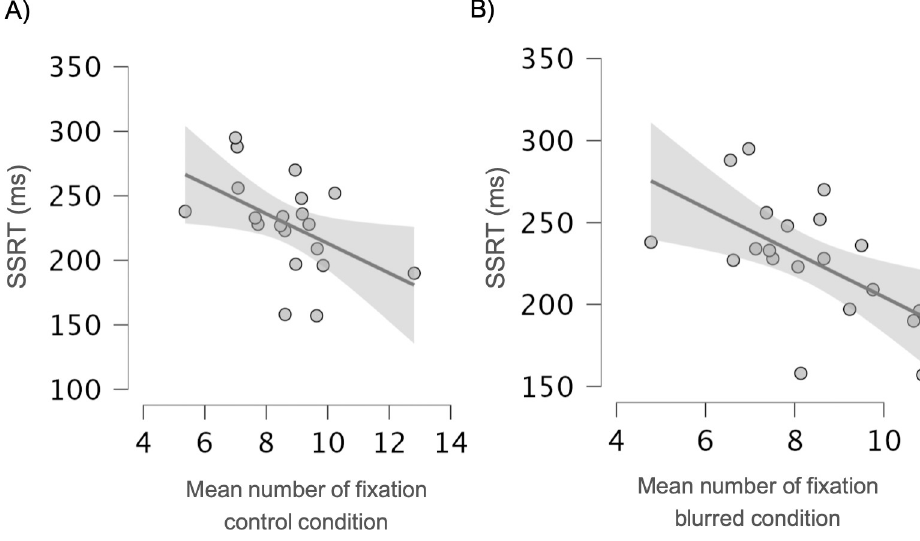
Fig 4. Correlations between SSRT and mean number of fixations for A) the control condition B) the blurred condition.